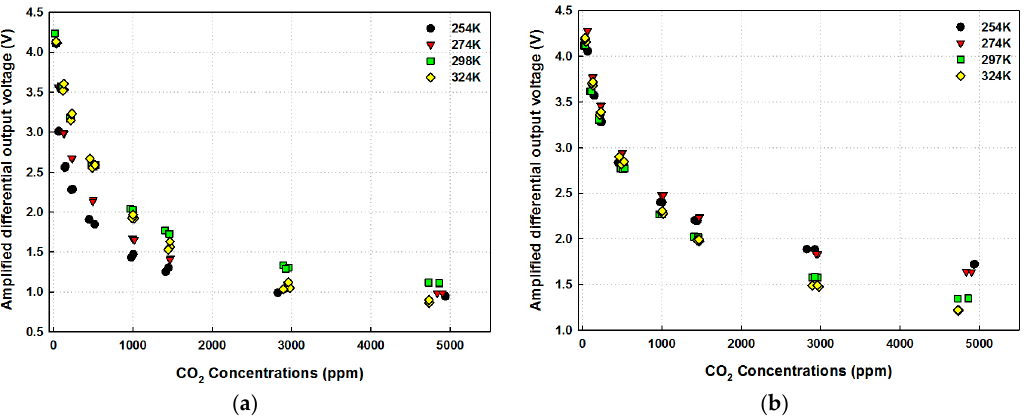
Figure 2. Amplified differential output voltages as a function of CO 2 concentration from 254 K to 324 K: ( a ) with normal reflectors; ( b ) with reflectors having a hydrophobic thin film.